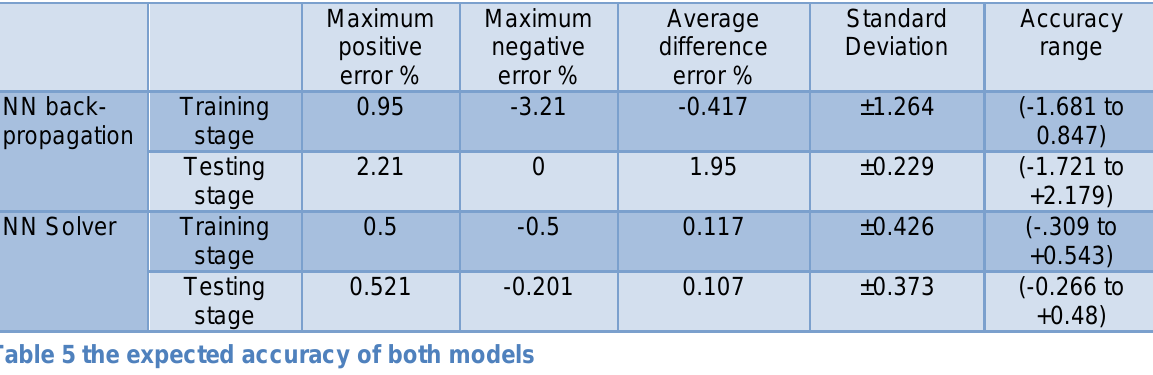
Table 5 the expected accuracy of both